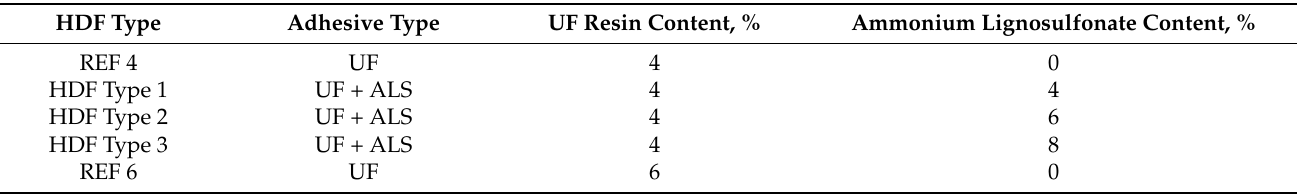
Table 1. Manufacturing parameters of HDF panels fabricated from industrial hardwood fibers bonded with UF resin and